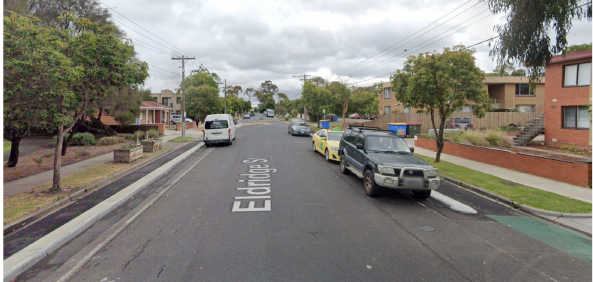
Figure 2. Google Street View screengrab of Eldridge Street Footscray, in Melbourne’s inner west, showing recent retrofit of cycling lanes onto an existing residential street to include 300 mm physical barrier curb separation with 800 mm cycle